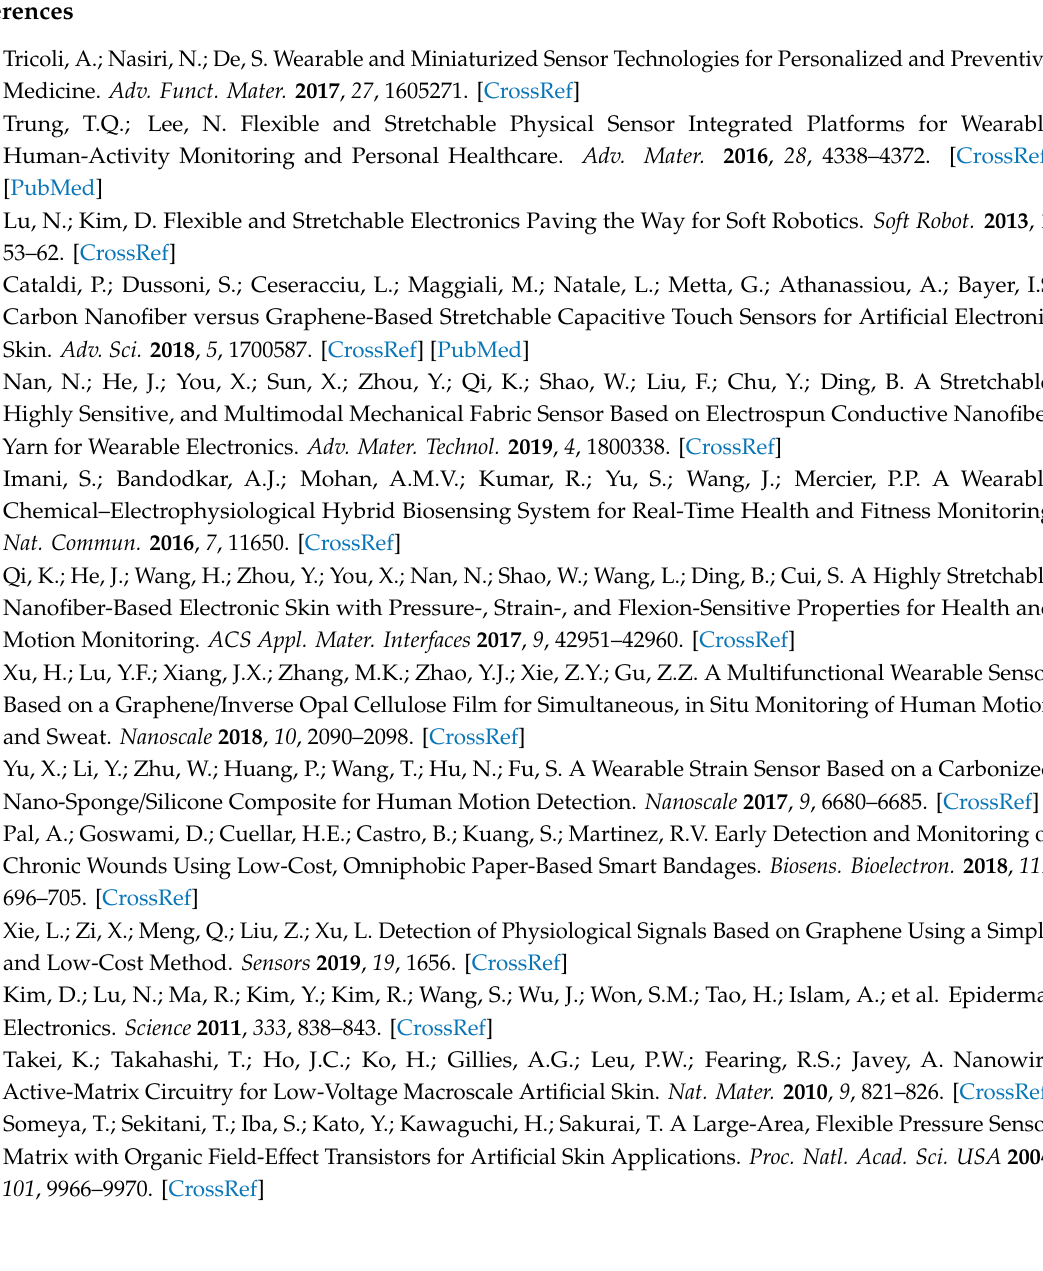
Figure S1: Sheet resistances of di ff erent densities of the silver NWs on the napkin, Figure S2: Optimization of the resolution of the patterned napkin tissue, Figure S3: Low-frequency approximation coe ffi cients of the eye blinking signals, Figure S4: High-frequency detail coe ffi cients of the eye blinking signals, Figure S5: Low-frequency approximation coe ffi cients of the wrist pulse, Figure S6: High-frequency detail coe ffi cients of the wrist